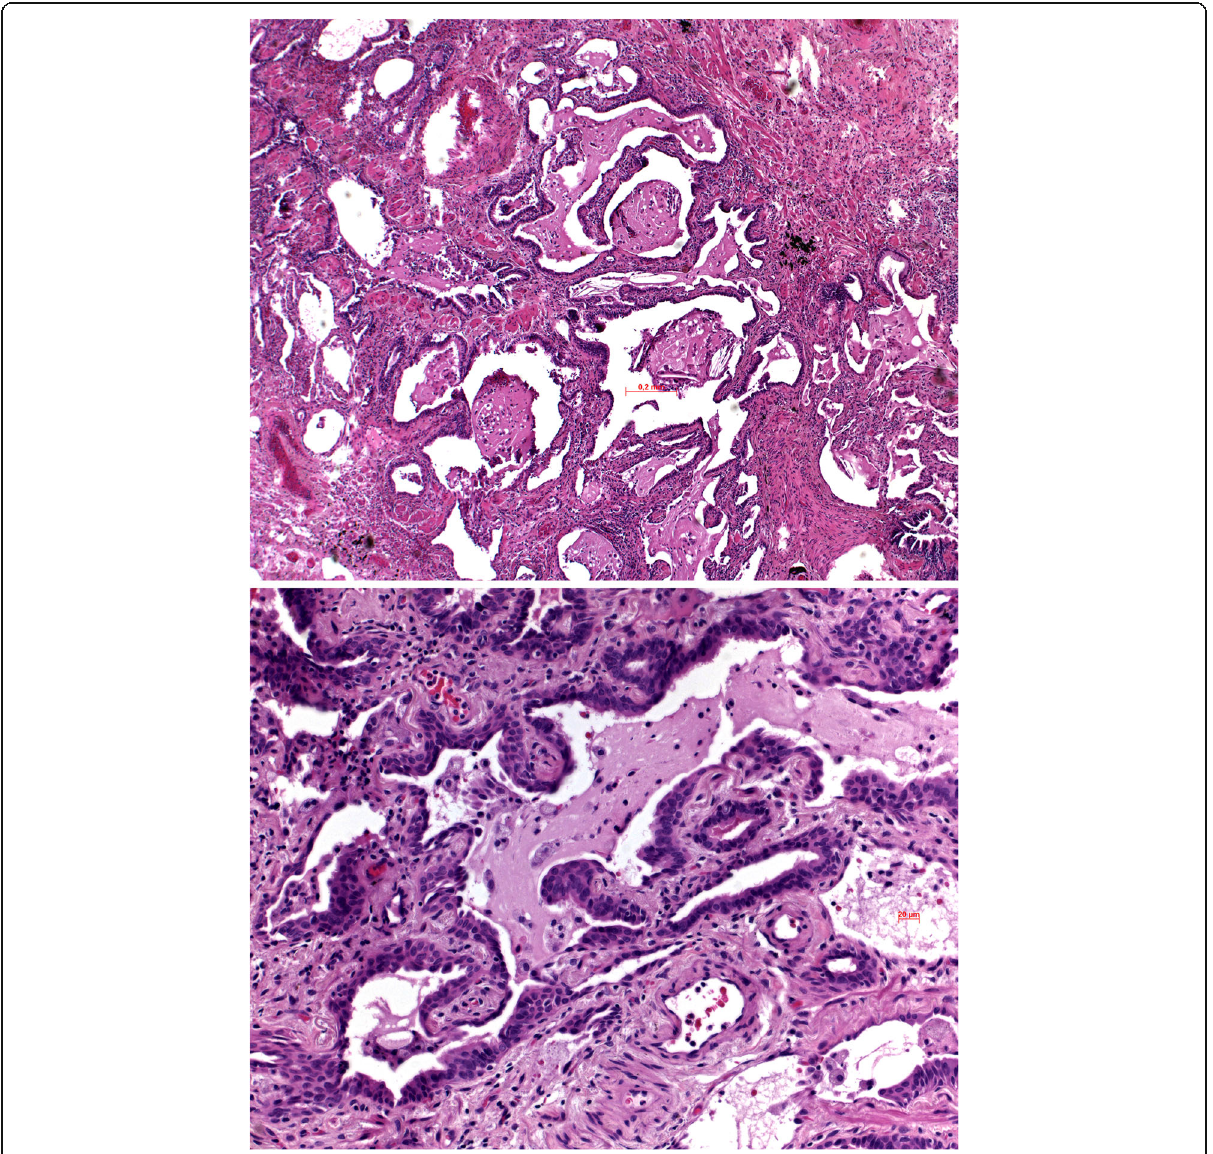
Fig. 3 Two cases of UIP with cystic remodeling, in the upper panel also fibrosis and mucus accumulation within the lumina. In the lower panel the epithelial metaplasia is illustrated with cuboidal cells of bronchiolar origin, replacing the pneumocytes. H&E, bars 200 and 20 μ